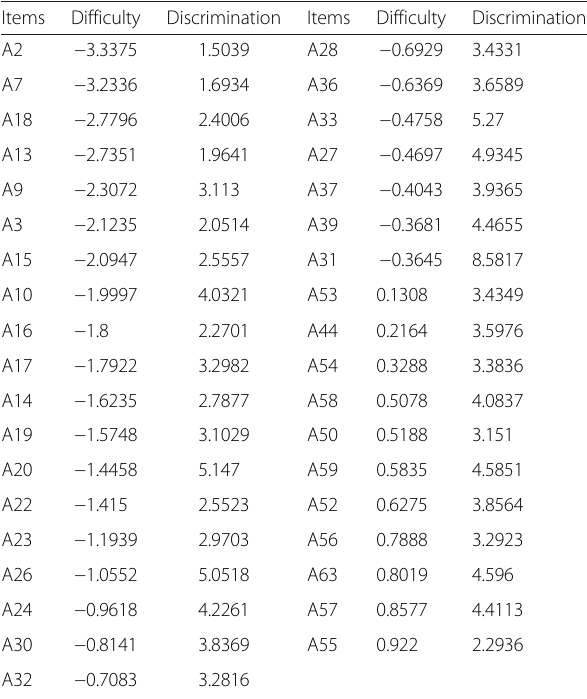
Table 3 Difficulty and discrimination power of items in version A of the TDE-II